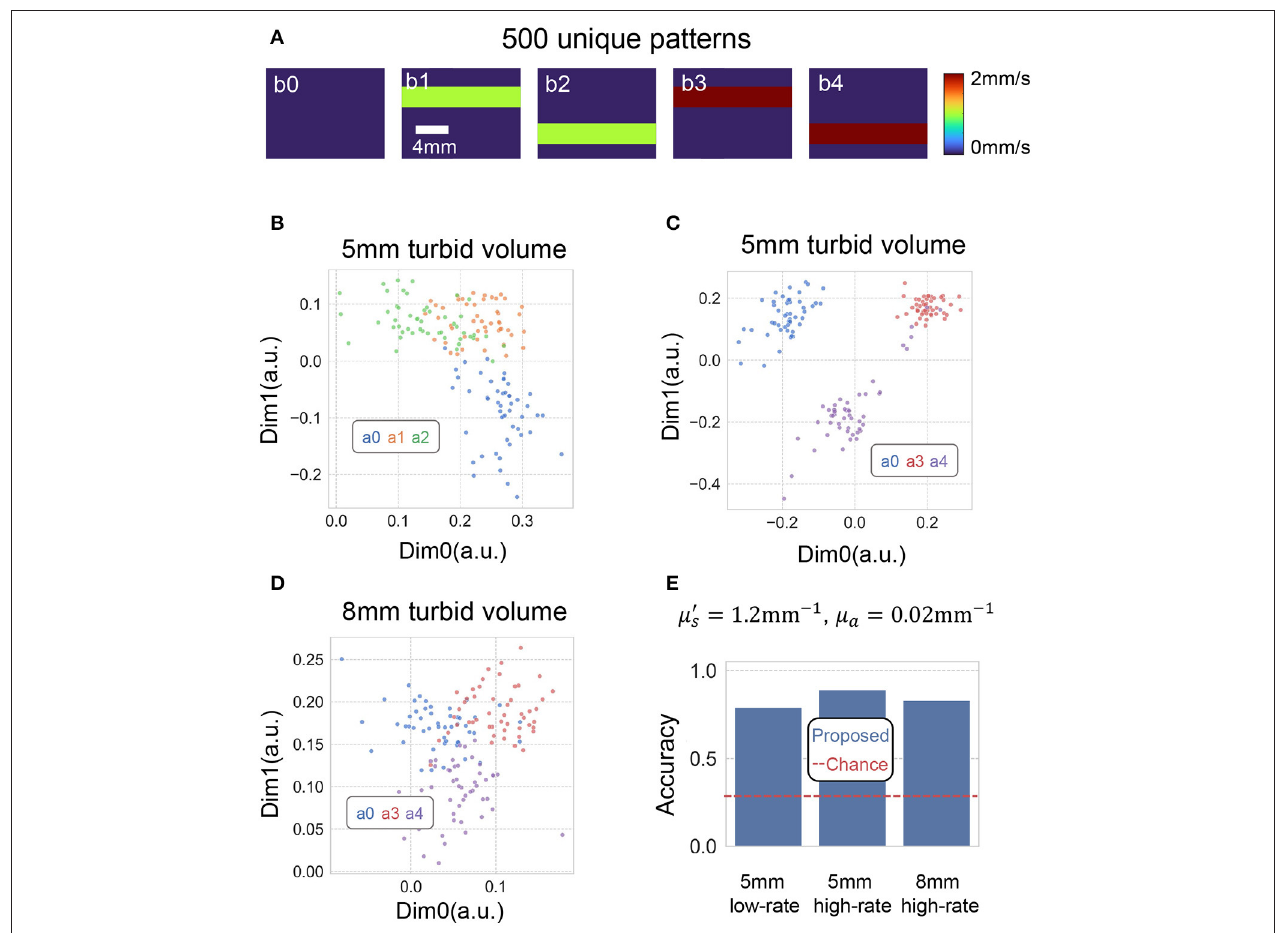
FIGURE 8 | (A) Depicts decorrelation events we attempted to separate. Those events were generated by placing two 3 mm diameter tubes filled with scattering volume placed underneath 5–8 liquid phantom. The scattering liquid in the tube either did not flow, or flowed at 1.0 and 2.0 mm/s, driven by two syringe pumps. (B,C) Plots two of the eight dimensions of the embedding using proposed method, when the perturbation is underneath 5 mm. (D) Plots two of the eight dimensions of the embedding using proposed method, when the perturbation is underneath 8 mm. (E) Barplots of the classification accuracy of the proposed method using 0.2 s integration time. The red dashed line plots the baseline of chance, which is 0.33 for a three-category classification